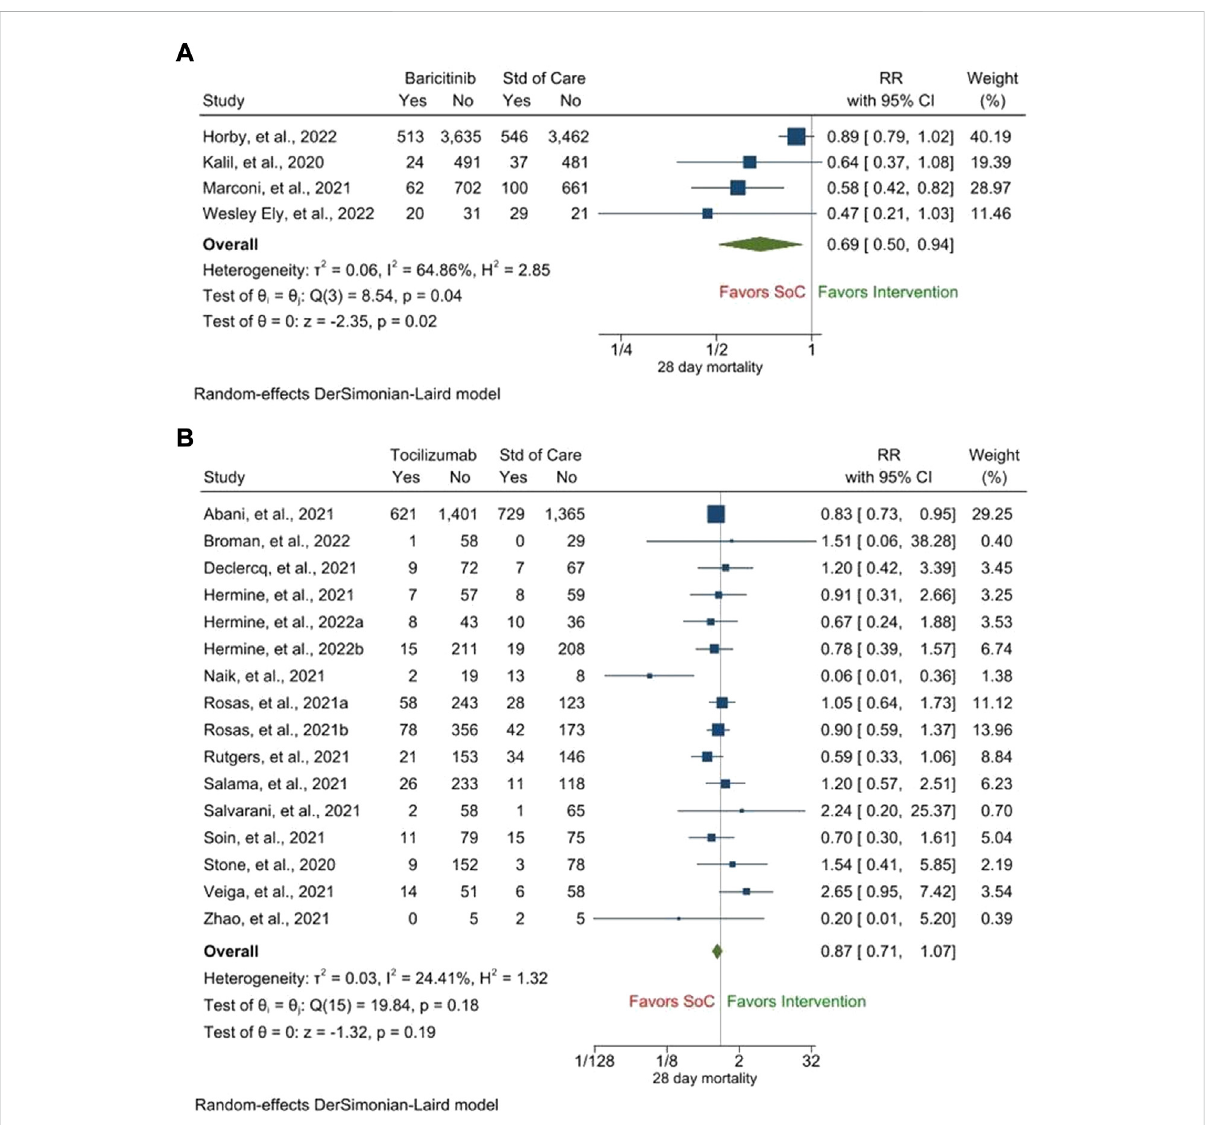
FIGURE 2 28-day mortality following treatment with baricitinib (A) and tocilizumab (B) as compared to that following treatment with the standard of care